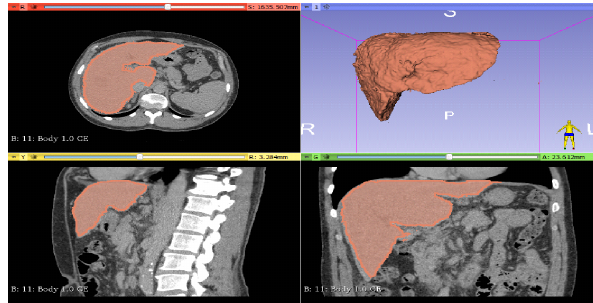
Figure 5: Manual segmentation for liver in 3D Slicer